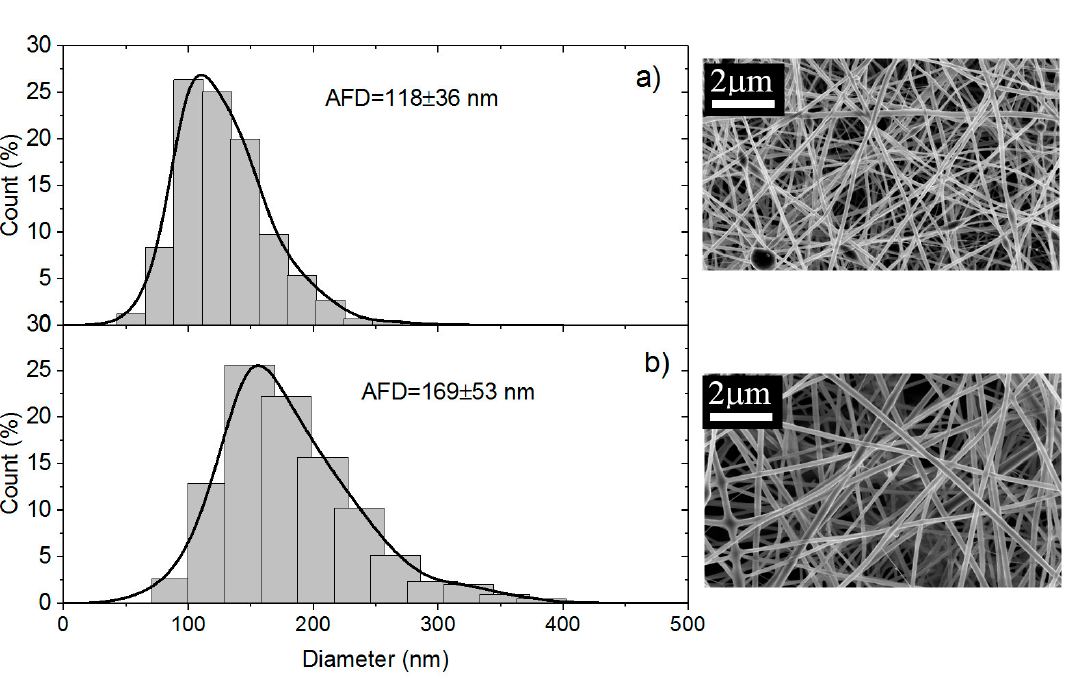
Figure 9. Diameter distribution of chitosan/PEO fibers expressed as a function of the count of fibers in % for ( a ) PEO M W = 10 6 at the concentration of 5% mixed with chitosan solution and ( b ) PEO M W = 10 6 added in powder form.